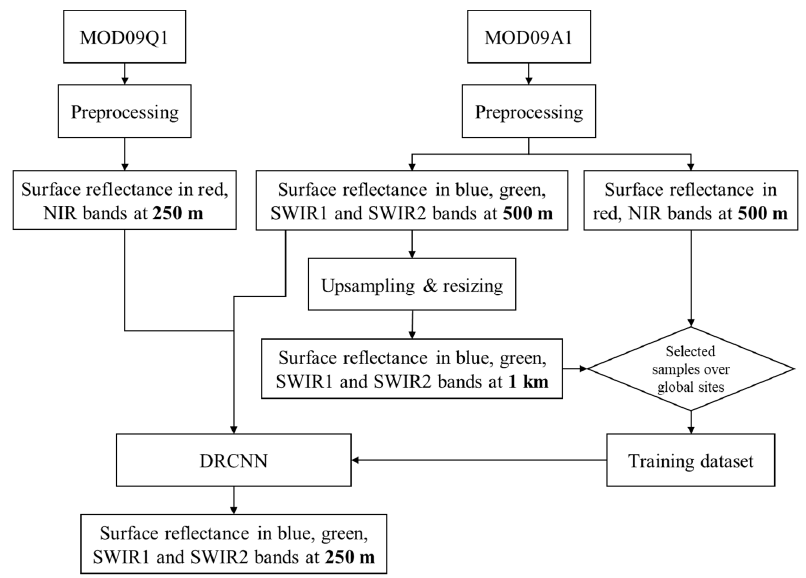
Figure 1. Flowchart of downscaling the MOD09A1 product to generate surface reflectance at 250 m resolution using the DRCNN.